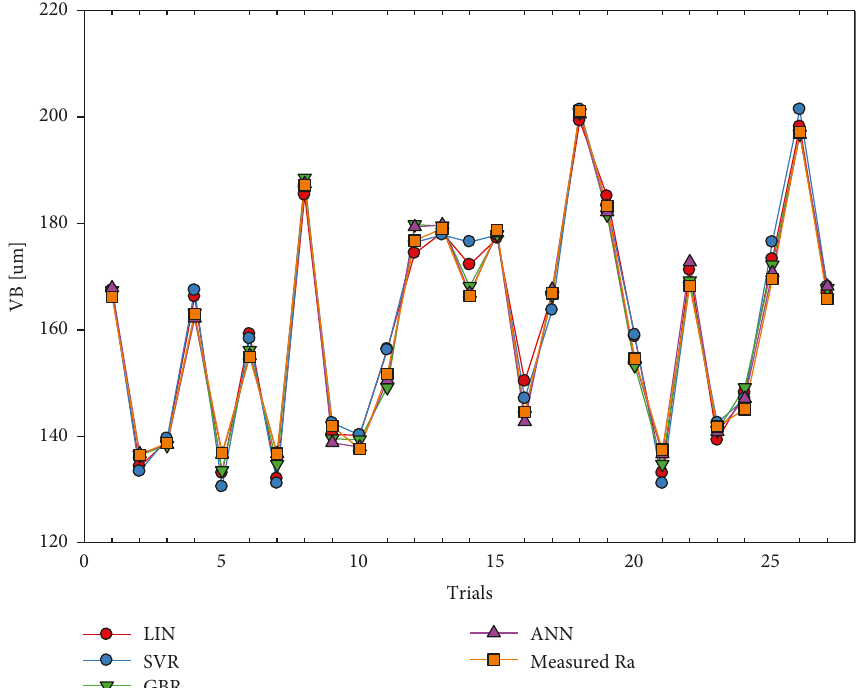
Figure 11: Comparison of experimental measurement and prediction of VB on the testing